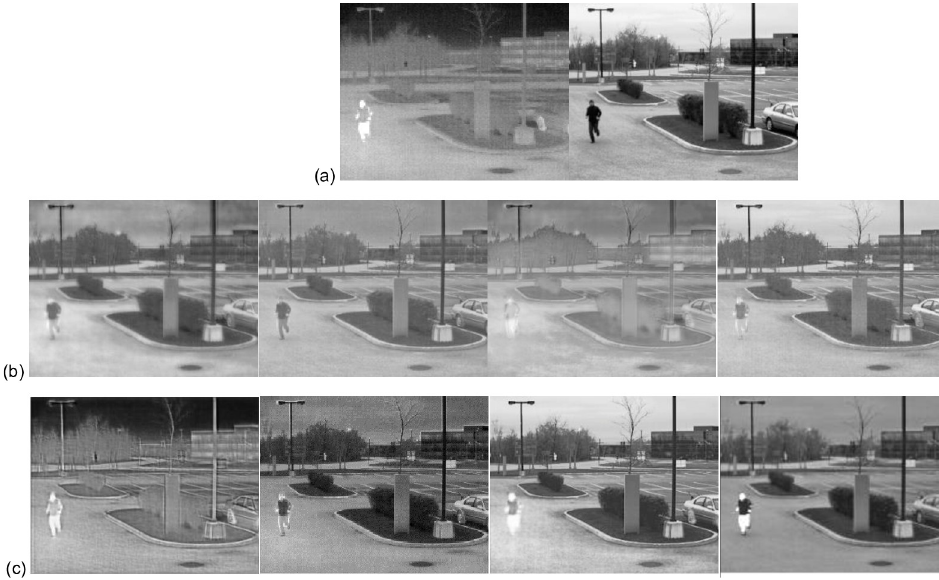
Fig 13. Qualitative comparison for 20th frame of Trees and runner from the INO dataset. (a) the infrared and visible images.(b) the fusion results of FusionGAN, GANMcC, MDLatLRR, and NestFuse. (c) the fusion results of ResNetFusion, SEDRFuse, STDFusionNet, and